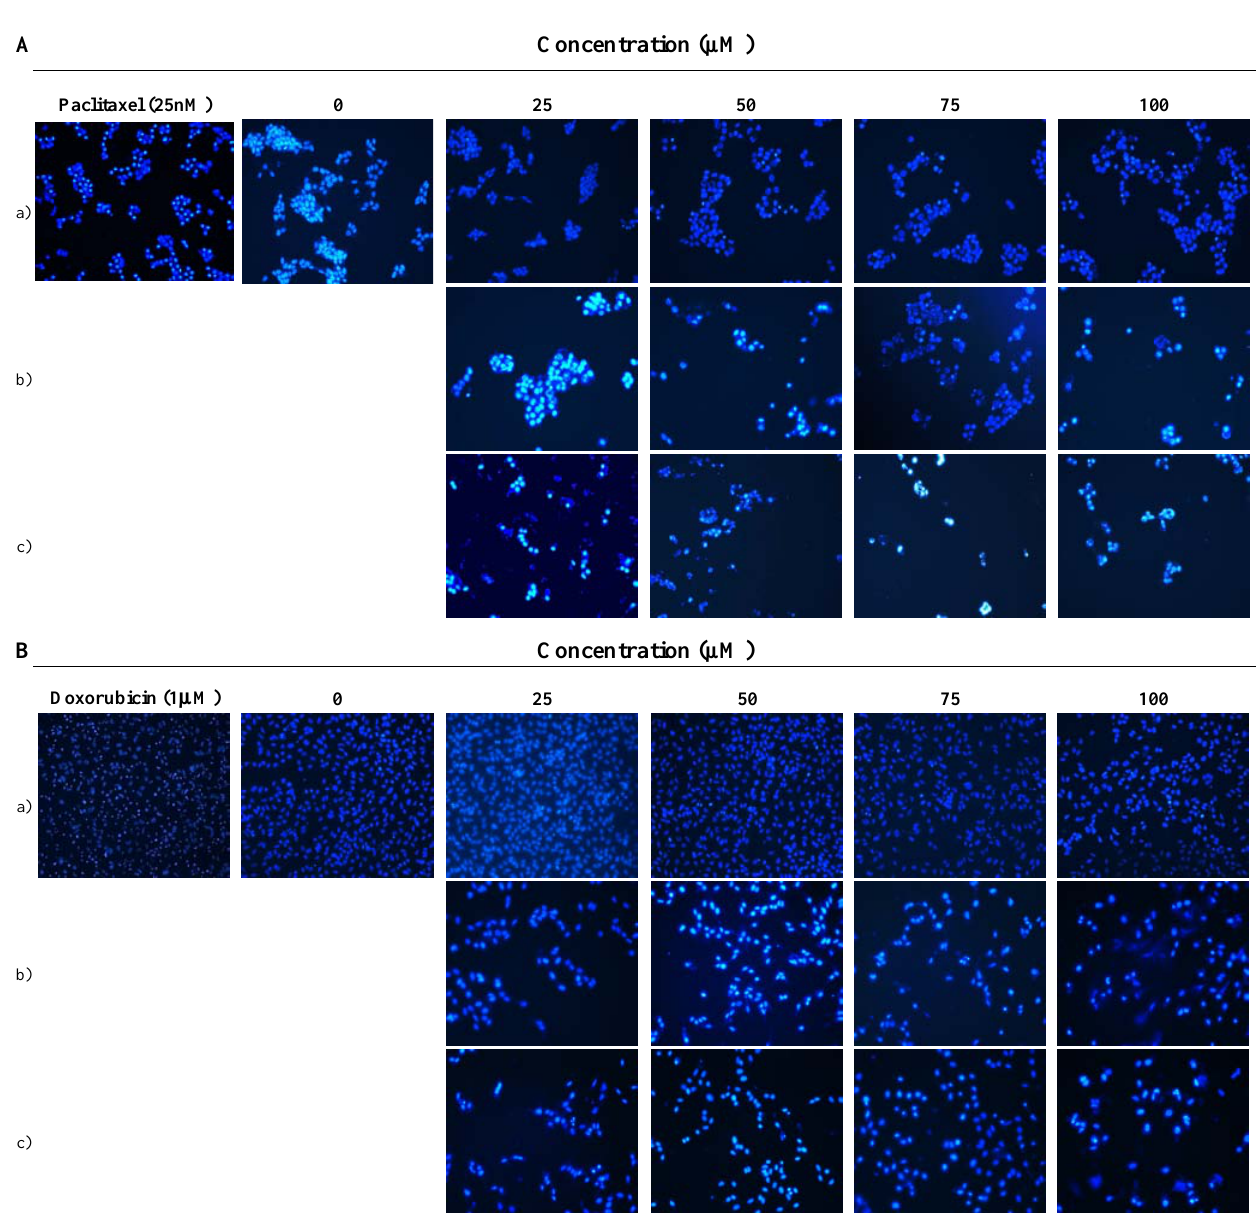
Figure 4. 9'- O -methylvibsanol (3) treated MCF-7 cells were stained by Ho33342. Nuclei morphologic changes observed by fluorescent microscopy (200 ×). (A) MCF-7, (B) A549 cells,